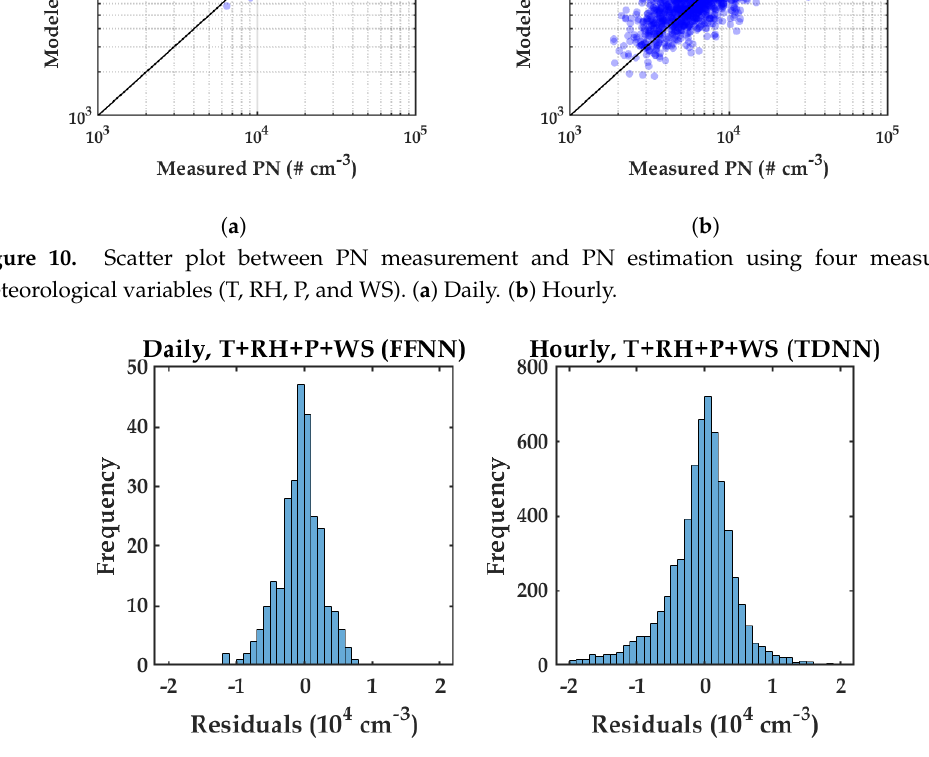
Figure 11. Histograms of residual error between the reference instrument and PN estimation using four measured variables (T, RH, P, and